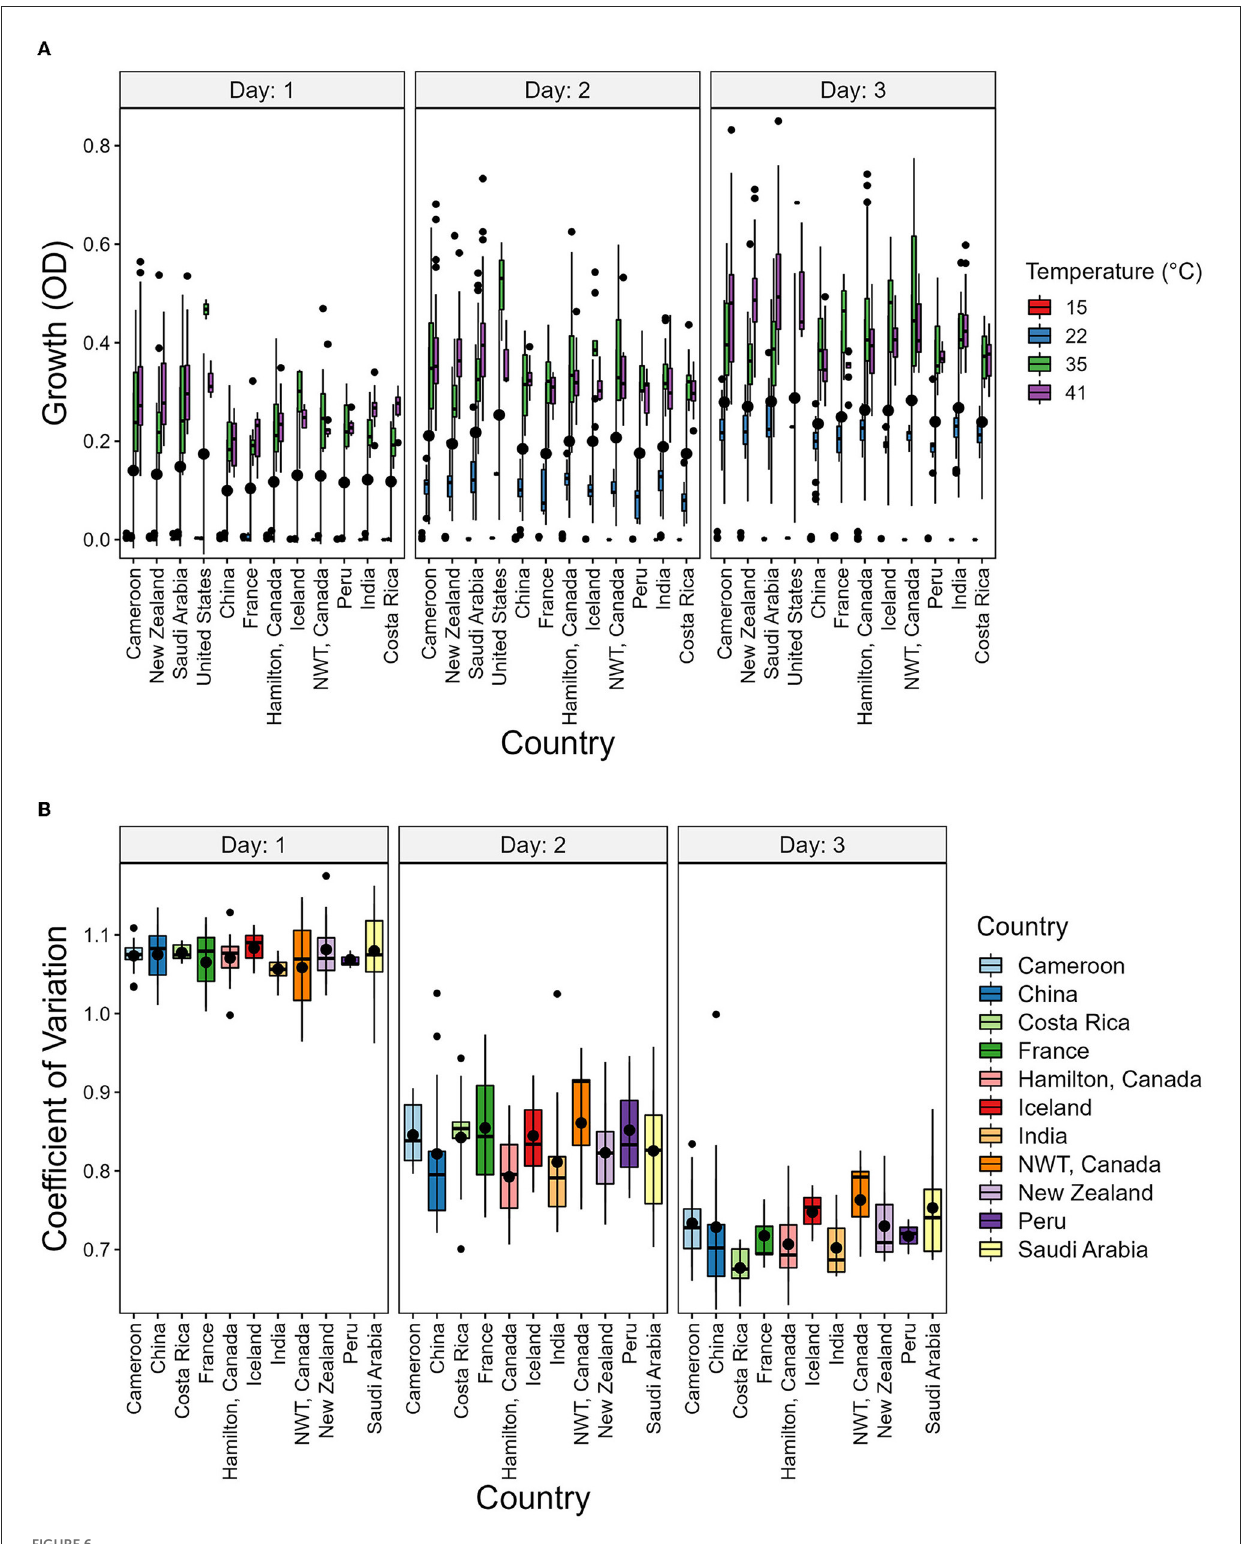
FIGURE6 Country of origin has no significant contribution to strain growth and to coefficient of variation (CV). (A) Boxplot showing the growth of strains grouped by country and Temperature. (B) Boxplot showing the CV of strains grouped by country. The CV was calcuated as the ratio of variance to the mean using the growth values of each